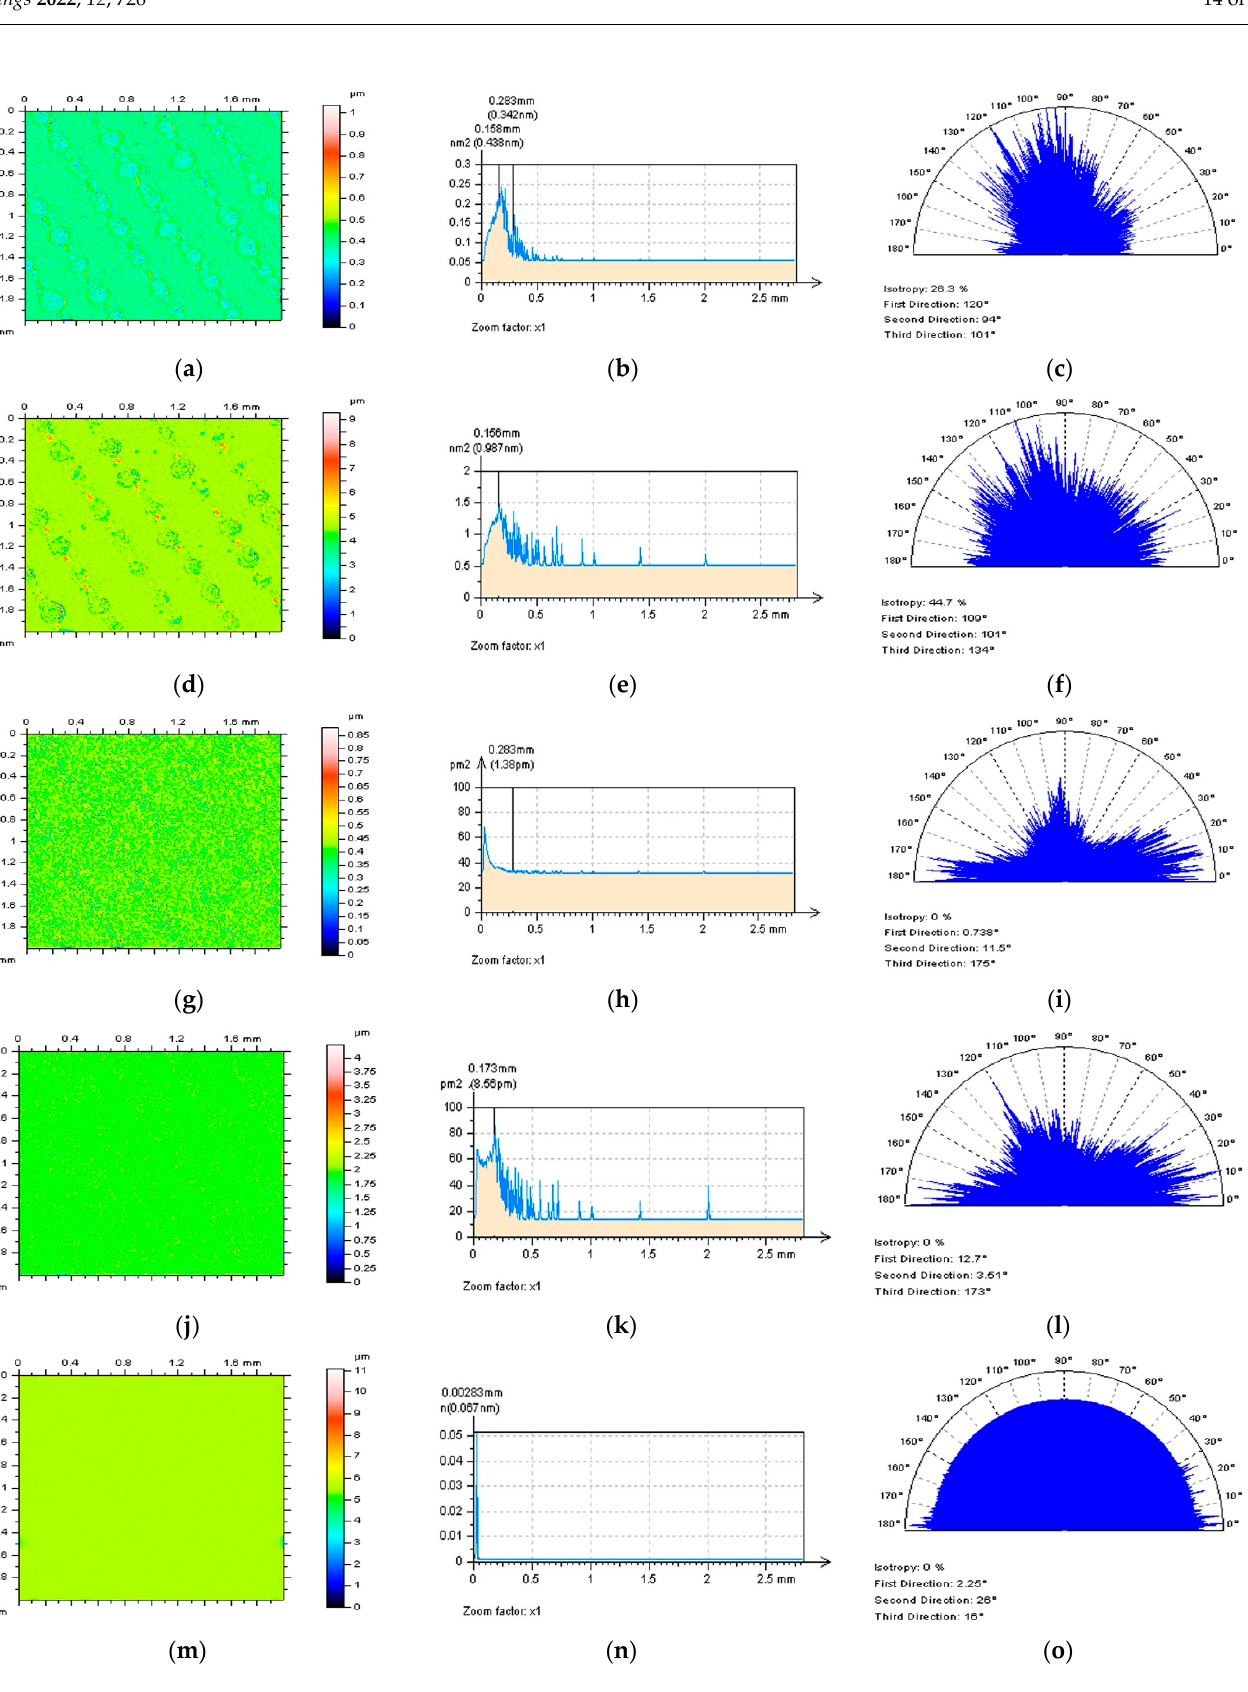
Figure 7. Analysis of a HFNS (left column), their PSDs (middle) and TDs (right column) received from a plateau ‐ honed cylinder surface containing oil pockets by usage of: GF ( a – c ), RGF ( d – f ), SF